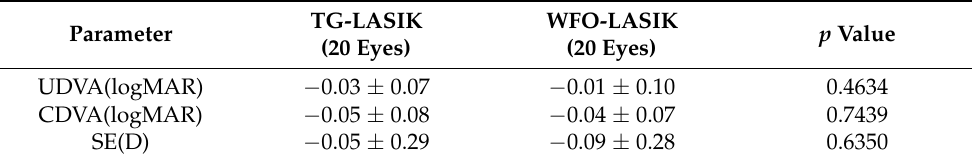
Table 2. Postoperative visual acuity and spherical equivalent at 3